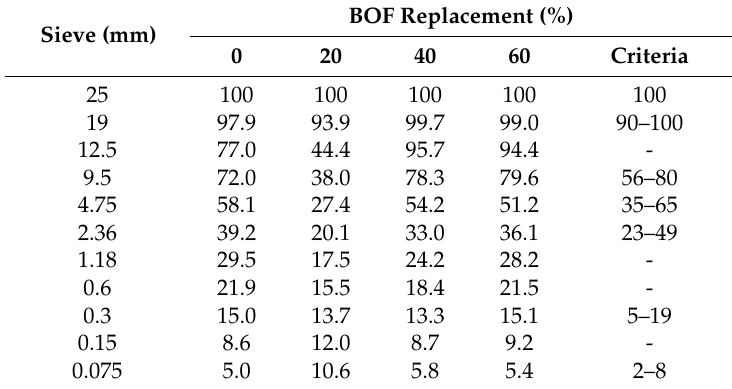
Table 4. Sieve distribution (stone mastic asphalt (SMA)-graded mixture).